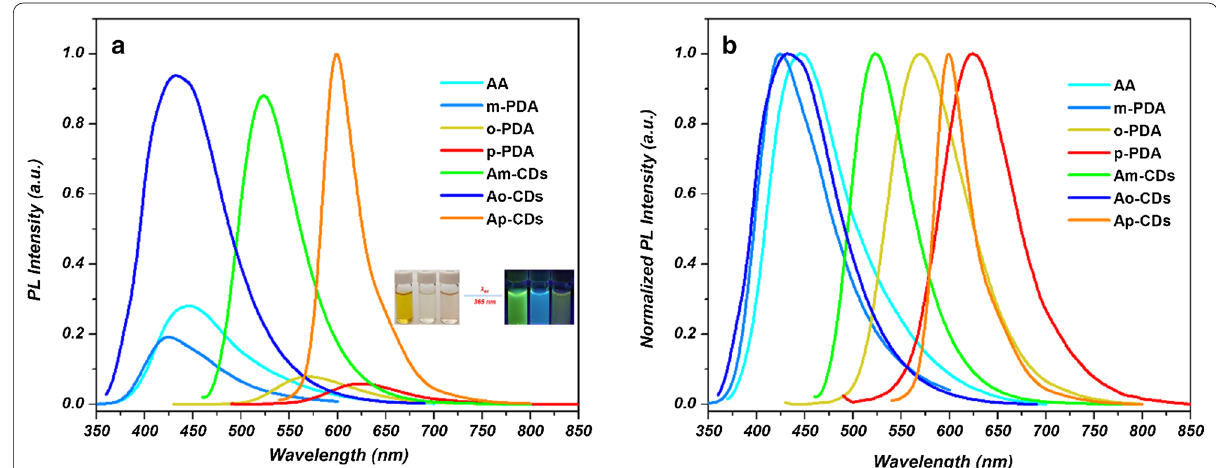
Fig. 1 a Fluorescence spectra, and b normalized fluorescence spectra of A x -CDs and various precursor materials. Inset: Photographs of A m -CDs, A o -CDs, and A p -CDs dispersed in water under natural light (left), and under UV irradiation ( λ ex